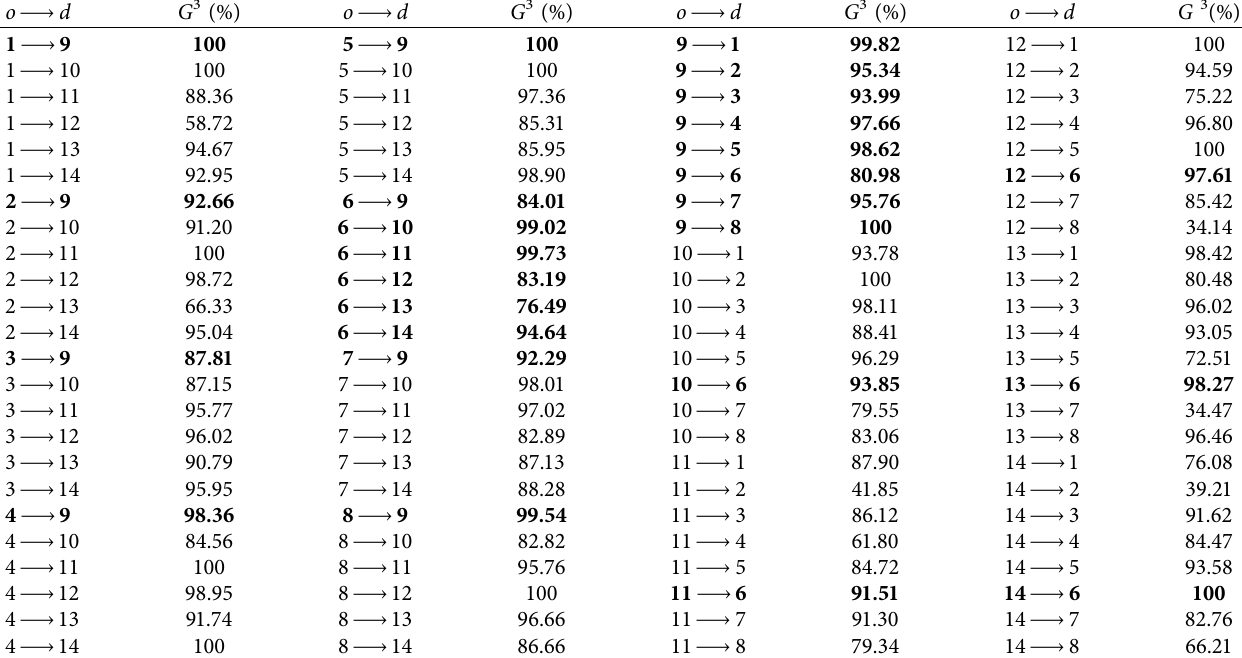
Table 4: The results of demand acceptance rate of COSCO Shipping in Scenario